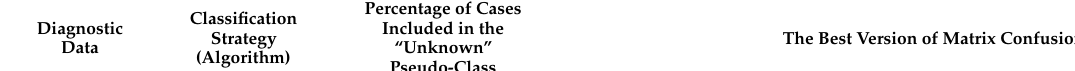
Table 3. Confusion matrices that have been achieved in the latest of the published studies pertaining to the new research trend in drill condition monitoring [38] for a different forced size of the “Unknown”